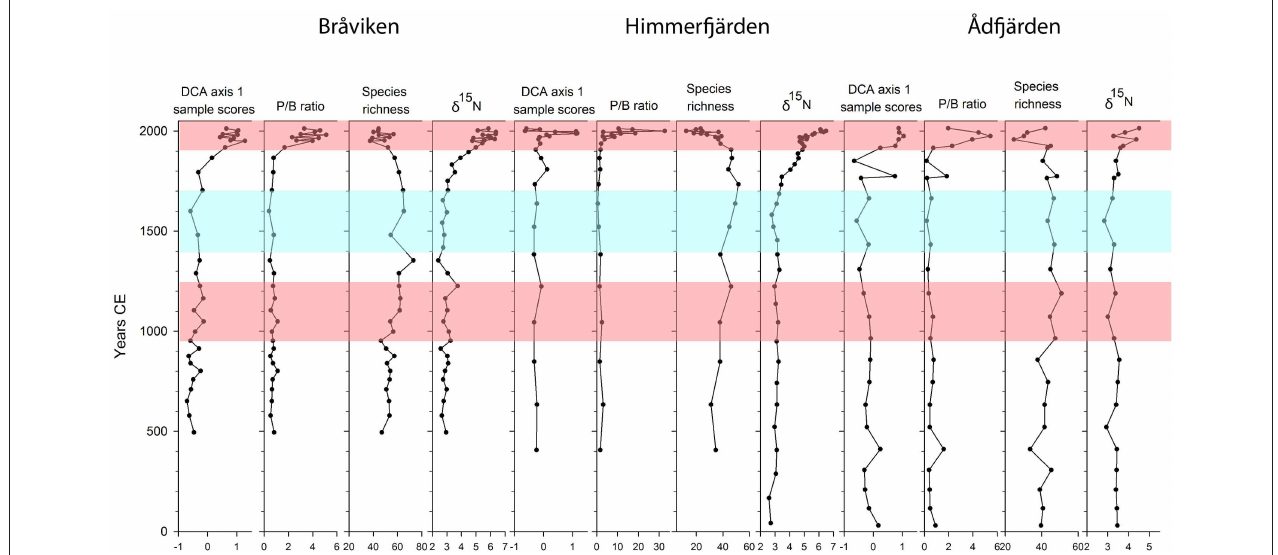
FIGURE 8 | Summary figure showing axis 1 sample scores from a Detrended Correspondence Analysis (DCA), the pelagic/benthic (P/B) ratio, diatom species richness, and changes in the nitrogen stable isotope δ 15 N. DCA axis 1 summarizes trends and compositional changes in the diatom dataset over time. Medieval Climate Anomaly and Modern Warm Period are marked in red, and Little Ice Age in blue. These time periods are defined as by Mann et al. (2009) and Harland et al.